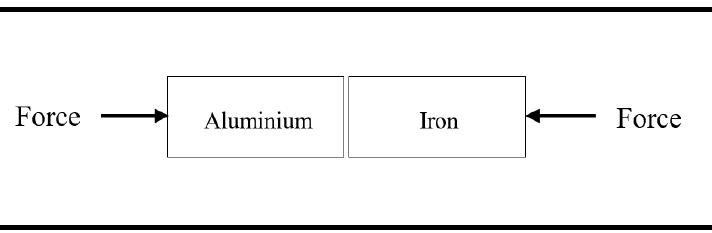
Figure 2. Diagram showing the direction of pressure application.